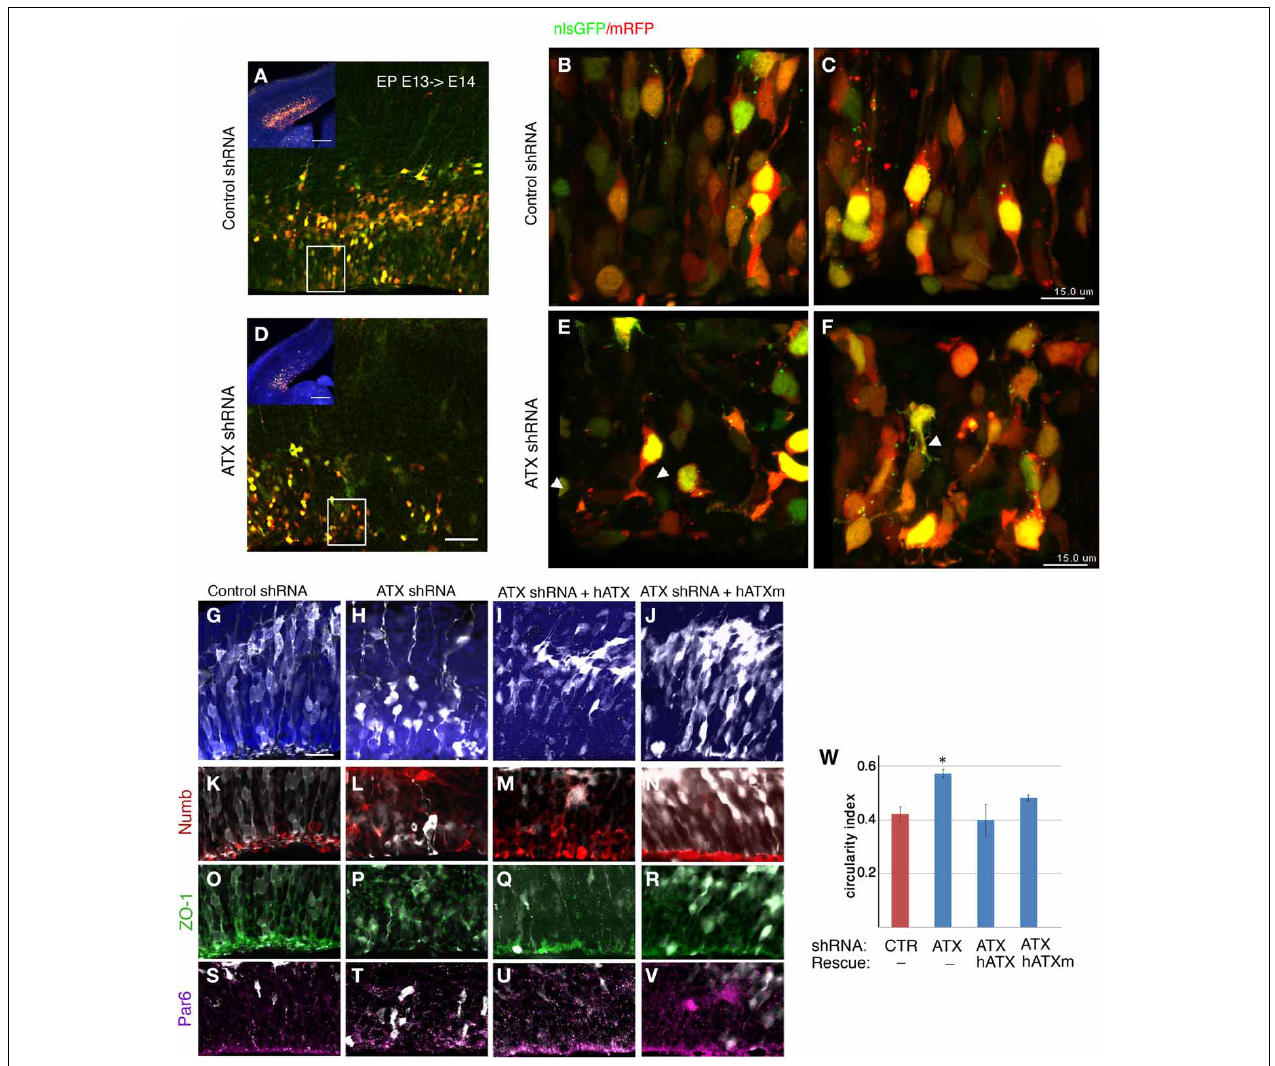
FIGURE 4 | ATX knockdown affects the radial progenitors adhesion and VZ polarity. (A–E) coronal sections from E14 electroporated brains. E13 embryos co-electorporated with control shRNA, dsRed and NLS-GFP (A–C) or with Atx shRNA (D–F) . Lower magnification is shown in (A,D) . White rectangle in panels (A,D) indicate area magnified in (B) and (E) respectively. White arrowheads point at endfeet that are not tethered to the apical surface of the VZ following ATX shRNA introduction. (C–H) ATX knockdown impairs polarity at the VZ and affects organization and morphology of cells. (G–V) E15 brains that had been electroporated at E14 are depicted. Whereas in the control brains (G) most of the cells (white, GFP) exited the VZ, upon ATX knockdown (H) cells were generally reside within the VZ. ATX knockdown distrups the structure of the VZ. ATX knocked-down cells exhibited a long and crooked radial process, and